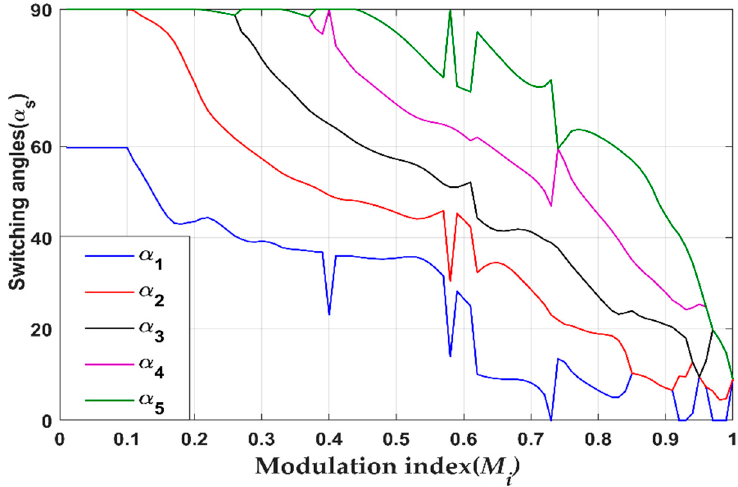
Figure 4. Switching angles at different modulation index.